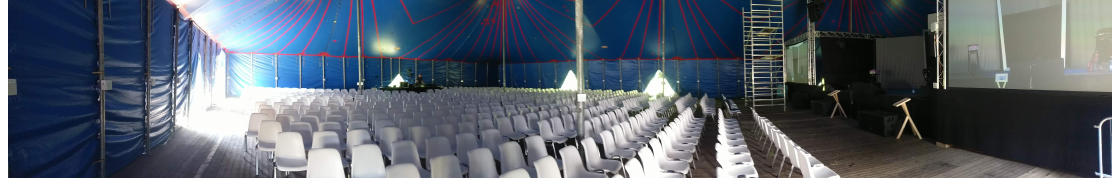
Figure 14. A photograph of the Nucleus tent environment.